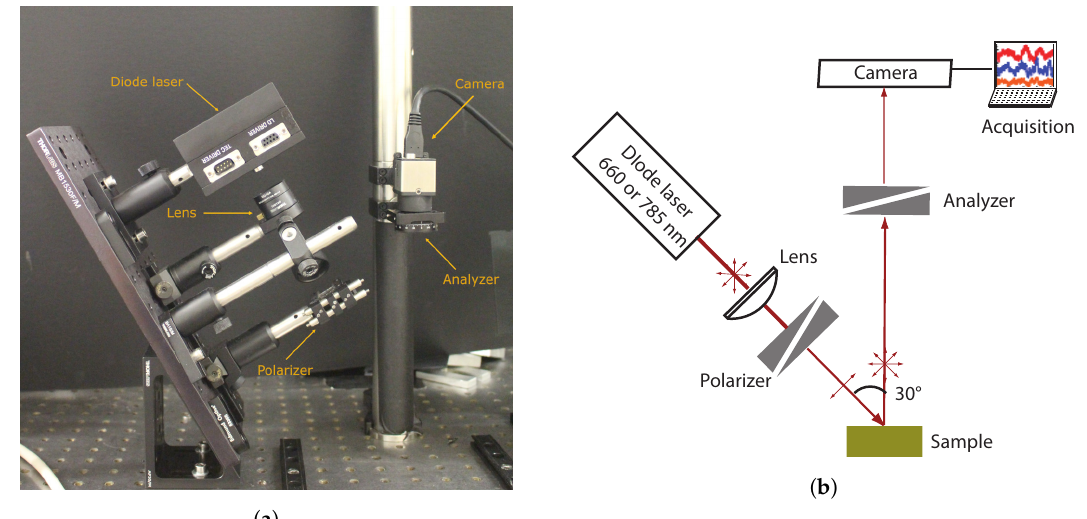
Figure 1. Experimental setup of speckle measurements: ( a ) image and ( b )